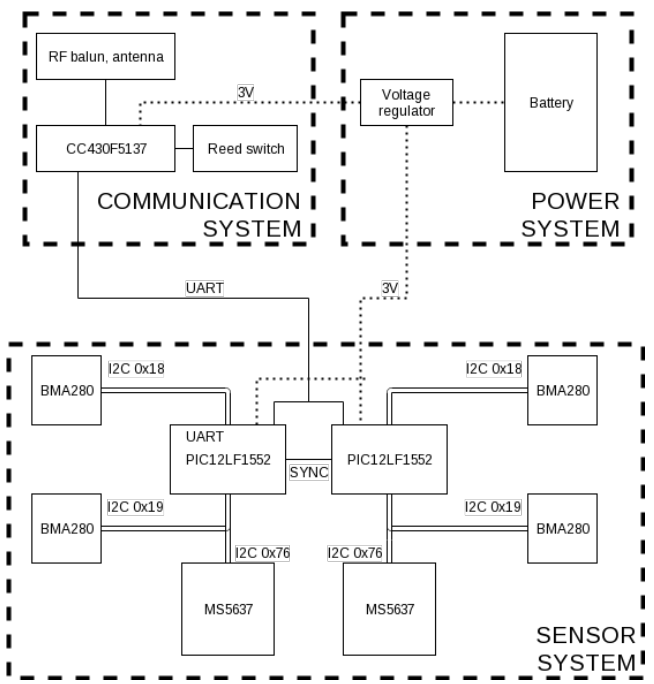
Figure 1. Block diagram of the system, consisting of the three